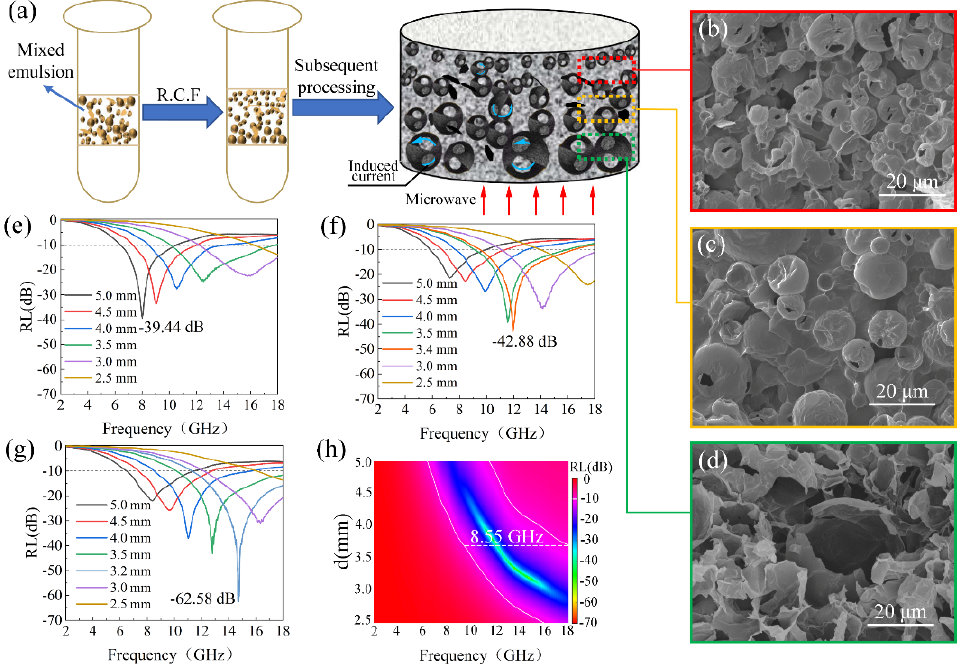
Figure 8. Effect of cell distribution on the microwave absorption performance. ( a ) Schematic description of OCGA-G. SEM images of ( b ) top region, ( c ) middle region and ( d ) bottom region of OCGA-G. ( e ) RL of OCGA-m. ( f ) RL of OCGA-P. ( g ) RL and ( h ) EAB of OCGA-G.